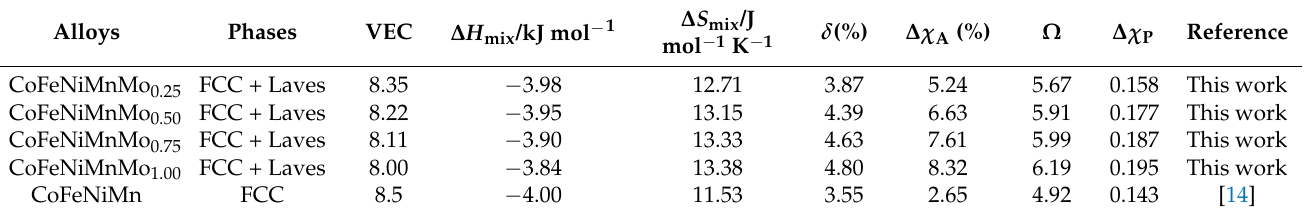
Table 3. (cid:5)(cid:138)(cid:149)(cid:140)(cid:158)(cid:149)(cid:138)(cid:157)(cid:142)(cid:141)(cid:561)(cid:159)(cid:138)(cid:149)(cid:158)(cid:142)(cid:156)(cid:561)(cid:152)(cid:143)(cid:561)(cid:159)(cid:138)(cid:149)(cid:142)(cid:151)(cid:140)(cid:142)(cid:561)(cid:142)(cid:149)(cid:142)(cid:140)(cid:157)(cid:155)(cid:152)(cid:151)(cid:561)(cid:140)(cid:152)(cid:151)(cid:140)(cid:142)(cid:151)(cid:157)(cid:155)(cid:138)(cid:157)(cid:146)(cid:152)(cid:151)(cid:561)(cid:507)(cid:24)(cid:7)(cid:5)(cid:508)(cid:496)(cid:561)(cid:142)(cid:151)(cid:157)(cid:145)(cid:138)(cid:149)(cid:153)(cid:162)(cid:561)(cid:152)(cid:143)(cid:561)(cid:150)(cid:146)(cid:161)(cid:146)(cid:151)(cid:144)(cid:561)(cid:507)(cid:775) H mix ), mix- (cid:146)(cid:151)(cid:144)(cid:561)(cid:142)(cid:151)(cid:157)(cid:155)(cid:152)(cid:153)(cid:162)(cid:561)(cid:507)(cid:775) S mix (cid:508)(cid:496)(cid:561)(cid:795)(cid:496)(cid:561)(cid:138)(cid:157)(cid:152)(cid:150)(cid:146)(cid:140)(cid:561)(cid:156)(cid:146)(cid:163)(cid:142)(cid:561)(cid:141)(cid:146)(cid:143)(cid:143)(cid:142)(cid:155)(cid:142)(cid:151)(cid:140)(cid:142)(cid:561)(cid:507) (cid:904) (cid:508)(cid:496)(cid:561)(cid:3)(cid:149)(cid:149)(cid:142)(cid:151)(cid:561)(cid:142)(cid:149)(cid:142)(cid:140)(cid:157)(cid:155)(cid:152)(cid:151)(cid:142)(cid:144)(cid:138)(cid:157)(cid:146)(cid:159)(cid:146)(cid:157)(cid:162)(cid:561)(cid:507)(cid:775) (cid:923) A ), and Pauling electro- (cid:151)(cid:142)(cid:144)(cid:138)(cid:157)(cid:146)(cid:159)(cid:146)(cid:157)(cid:162)(cid:561)(cid:507)(cid:775) (cid:923) P ) in the CoFeNiMnMo x alloys.